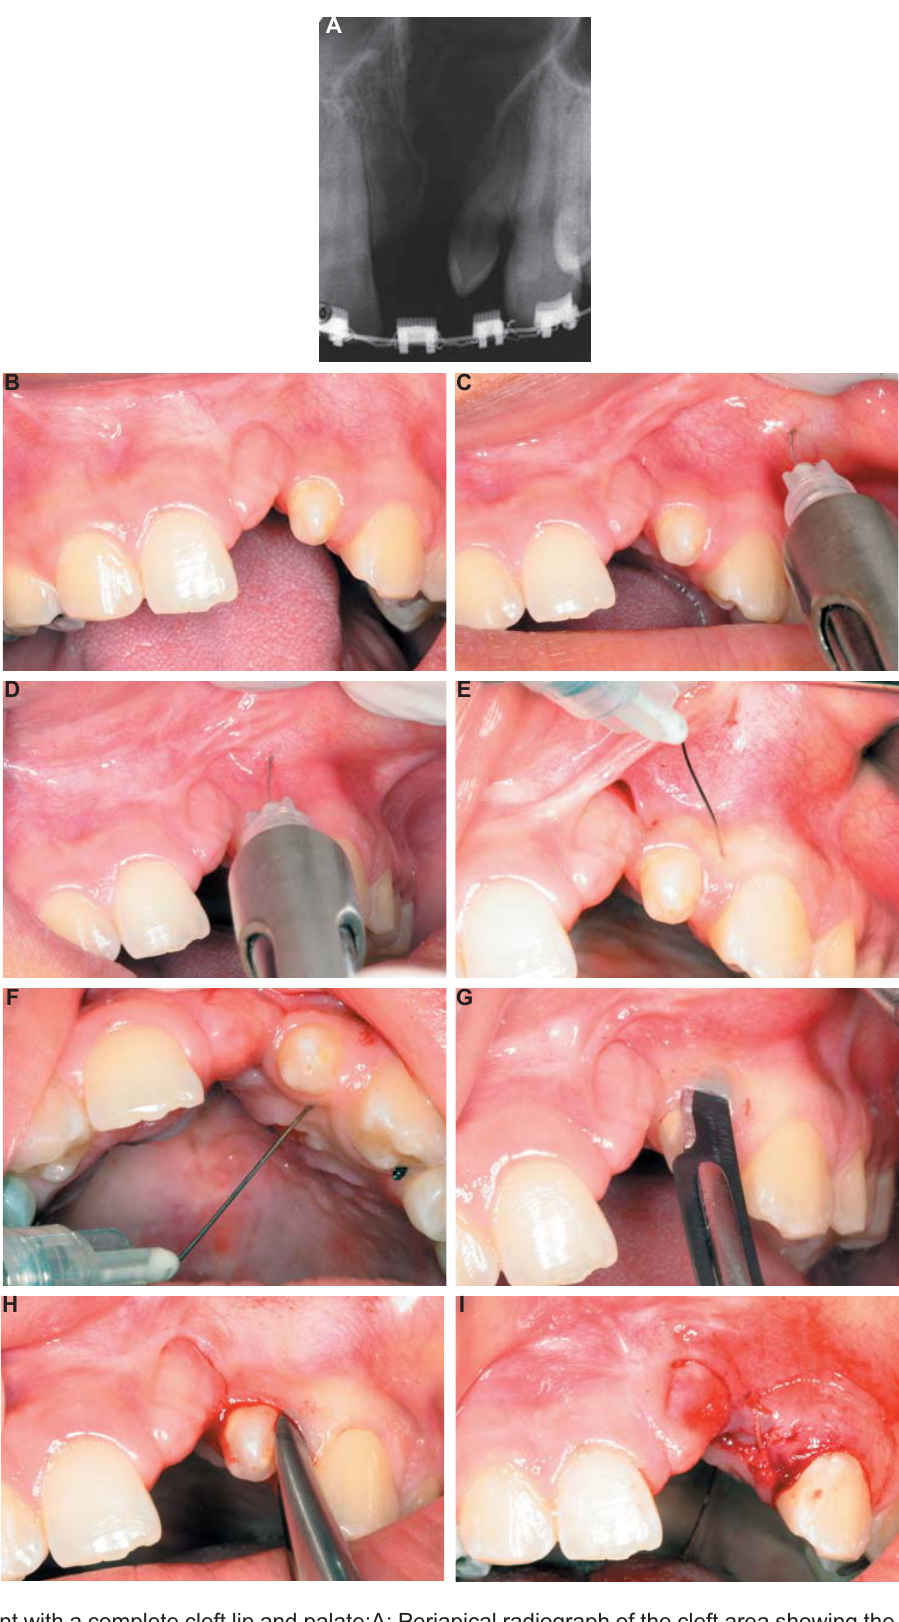
Figure 1- Patient with a complete cleft lip and palate:A: Periapical radiograph of the cleft area showing the supernumerary (cid:2)(cid:3)(cid:3)(cid:2)(cid:4)(cid:5)(cid:6)(cid:7)(cid:2)(cid:4)(cid:5)(cid:8)(cid:5)(cid:9)(cid:10)(cid:8)(cid:11)(cid:11)(cid:5)(cid:12)(cid:3)(cid:3)(cid:2)(cid:5)(cid:8)(cid:13)(cid:14)(cid:5)(cid:15)(cid:3)(cid:3)(cid:12)(cid:5)(cid:16)(cid:3)(cid:13)(cid:17)(cid:5)(cid:9)(cid:18)(cid:15)(cid:15)(cid:3)(cid:12)(cid:2)(cid:19)(cid:5)(cid:20)(cid:21)(cid:5)(cid:22)(cid:13)(cid:2)(cid:12)(cid:8)(cid:3)(cid:12)(cid:8)(cid:11)(cid:5)(cid:23)(cid:7)(cid:17)(cid:6)(cid:19)(cid:5)(cid:24)(cid:21)(cid:5)(cid:25)(cid:7)(cid:12)(cid:9)(cid:2)(cid:5)(cid:7)(cid:13)(cid:26)(cid:11)(cid:2)(cid:12)(cid:8)(cid:2)(cid:7)(cid:3)(cid:13)(cid:5)(cid:7)(cid:13)(cid:5)(cid:2)(cid:4)(cid:17)(cid:5)(cid:15)(cid:12)(cid:17)(cid:10)(cid:3)(cid:11)(cid:8)(cid:12)(cid:5)(cid:12)(cid:17)(cid:27)(cid:7)(cid:3)(cid:13)(cid:19)(cid:5)(cid:28)(cid:21)(cid:5)(cid:29)(cid:17)(cid:30)(cid:3)(cid:13)(cid:14)(cid:5) (cid:7)(cid:13)(cid:26)(cid:11)(cid:2)(cid:12)(cid:8)(cid:2)(cid:7)(cid:3)(cid:13)(cid:5)(cid:7)(cid:13)(cid:5)(cid:2)(cid:4)(cid:17)(cid:5)(cid:30)(cid:11)(cid:17)(cid:31)(cid:2)(cid:5)(cid:8)(cid:12)(cid:17)(cid:8)(cid:19)(cid:5)!(cid:21)(cid:5)(cid:22)(cid:13)(cid:26)(cid:11)(cid:2)(cid:12)(cid:8)(cid:2)(cid:7)(cid:3)(cid:13)(cid:5)(cid:7)(cid:13)(cid:5)(cid:2)(cid:4)(cid:17)(cid:5)(cid:10)(cid:8)(cid:12)(cid:27)(cid:7)(cid:13)(cid:8)(cid:11)(cid:5)(cid:27)(cid:7)(cid:13)(cid:27)(cid:7)(cid:23)(cid:8)(cid:5)(cid:3)(cid:31)(cid:5)(cid:2)(cid:4)(cid:17)(cid:5)(cid:9)(cid:18)(cid:15)(cid:17)(cid:12)(cid:13)(cid:18)(cid:10)(cid:17)(cid:12)(cid:8)(cid:12)"(cid:5)(cid:15)(cid:12)(cid:17)(cid:30)(cid:8)(cid:13)(cid:7)(cid:13)(cid:17)(cid:5)(cid:7)(cid:13)(cid:5)(cid:2)(cid:4)(cid:17)(cid:5)(cid:16)(cid:18)(cid:30)(cid:30)(cid:8)(cid:11)(cid:5)(cid:8)(cid:9)(cid:15)(cid:17)(cid:30)(cid:2)(cid:19)(cid:5) (cid:25)(cid:21)(cid:5)(cid:22)(cid:13)(cid:26)(cid:11)(cid:2)(cid:12)(cid:8)(cid:2)(cid:7)(cid:3)(cid:13)(cid:5)(cid:7)(cid:13)(cid:5)(cid:2)(cid:4)(cid:17)(cid:5)(cid:10)(cid:8)(cid:12)(cid:27)(cid:7)(cid:13)(cid:8)(cid:11)(cid:5)(cid:27)(cid:17)(cid:13)(cid:27)(cid:7)(cid:23)(cid:8)(cid:5)(cid:3)(cid:31)(cid:5)(cid:2)(cid:4)(cid:17)(cid:5)(cid:9)(cid:18)(cid:15)(cid:17)(cid:12)(cid:13)(cid:18)(cid:10)(cid:17)(cid:12)(cid:8)(cid:12)"(cid:5)(cid:15)(cid:12)(cid:17)(cid:30)(cid:8)(cid:13)(cid:7)(cid:13)(cid:17)(cid:5)(cid:7)(cid:13)(cid:5)(cid:2)(cid:4)(cid:17)(cid:5)(cid:15)(cid:8)(cid:11)(cid:8)(cid:2)(cid:8)(cid:11)(cid:5)(cid:8)(cid:9)(cid:15)(cid:17)(cid:30)(cid:2)(cid:19)(cid:5)#(cid:21)(cid:5)(cid:22)(cid:13)(cid:2)(cid:12)(cid:8)(cid:9)(cid:18)(cid:11)(cid:30)(cid:18)(cid:11)(cid:8)(cid:12)(cid:5)(cid:7)(cid:13)(cid:30)(cid:7)(cid:9)(cid:7)(cid:3)(cid:13)(cid:19)(cid:5) H:extraction procedure; 1I: